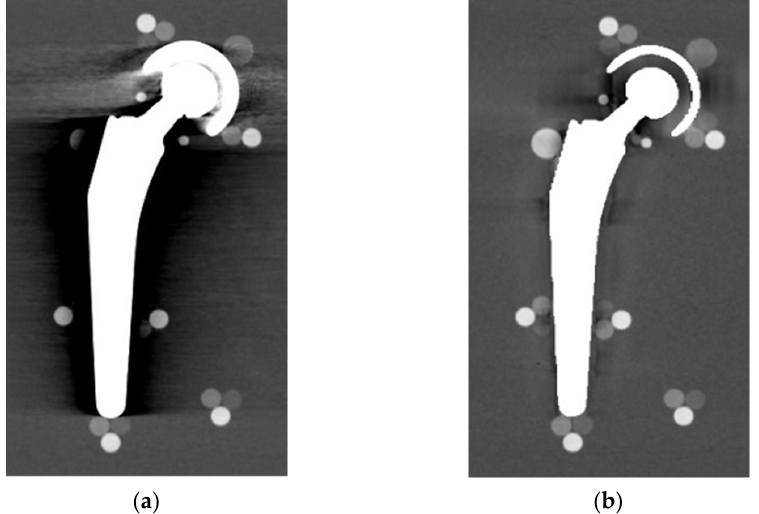
Figure 3. TI unilateral configuration, coronal reconstruction (bone CT visualization window WL:300, WW:1500 ( a ) virtual monochromatic imaging (VMI) reconstructed at 130 keV; and ( b ) virtual monochromatic reconstruction imaging (VMI) reconstructed at 130 keV + metal artifact reduction spectral (MARS) algorithm.